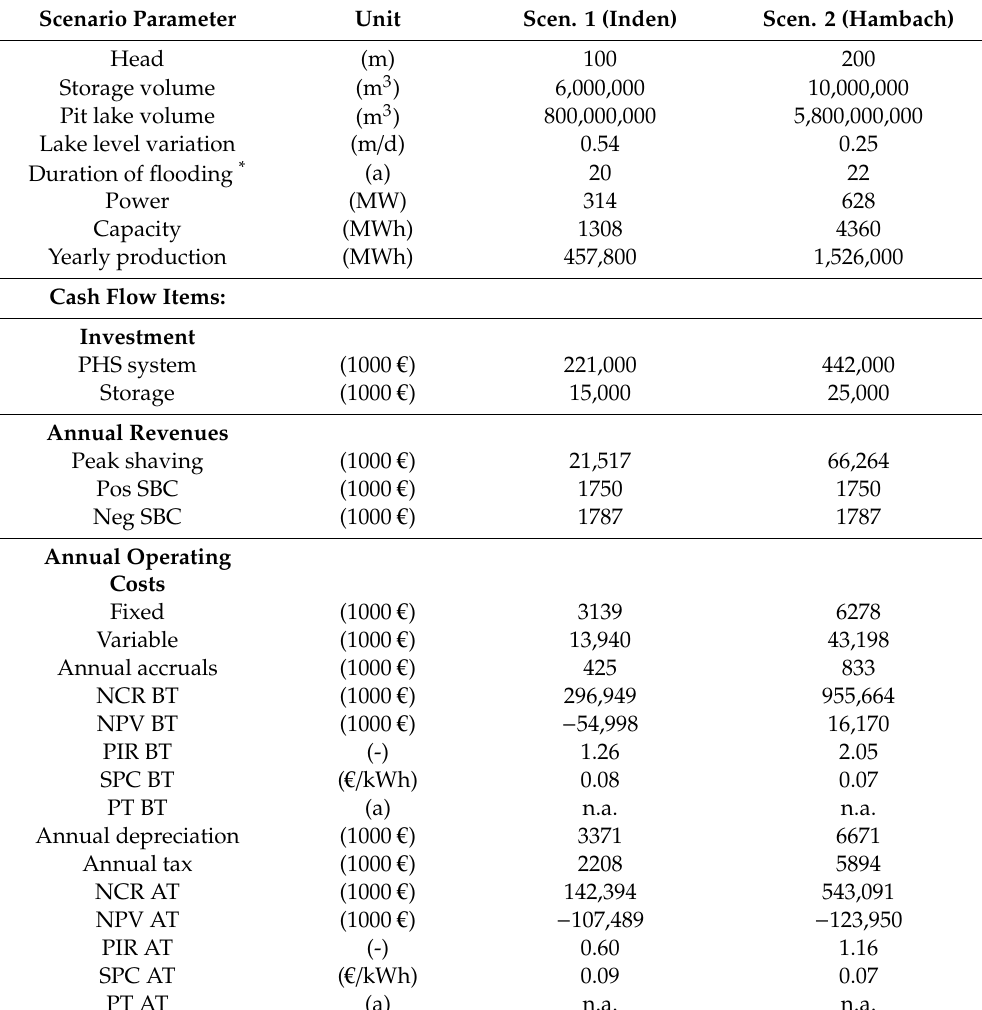
Table 11. Economic evaluation for both